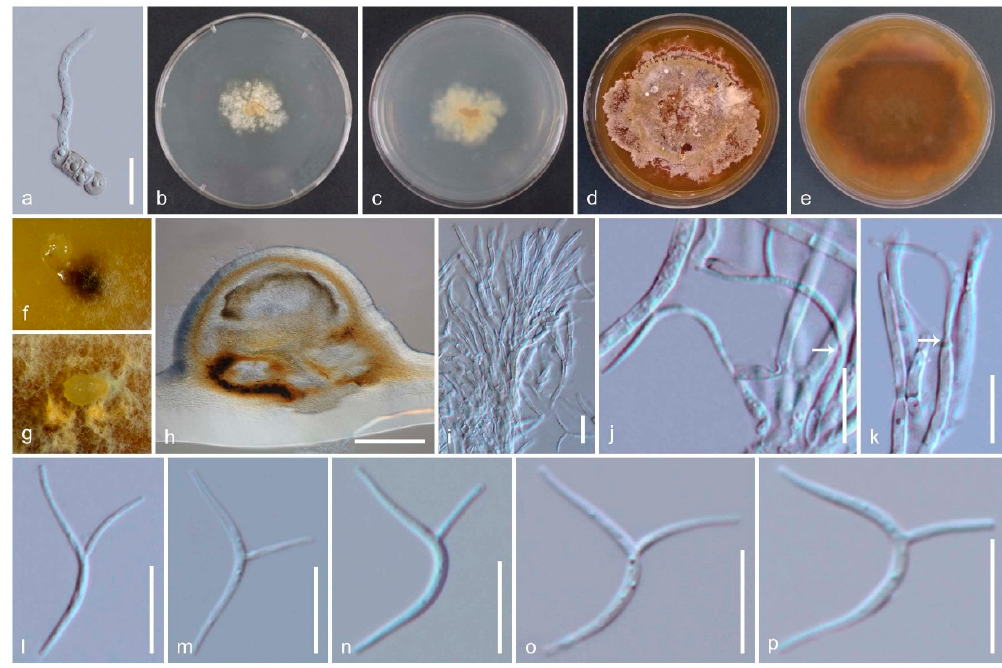
Figure 6. Asexual morph of Amphisphaeria curvaticonidia (MFLUCC 18-0620, ex-type living culture). ( a ) Germinating ascospore; ( b ) upper view, ( c ) reverse view of the 2 weeks old colony on PDA; ( d ) upper view, ( e ) reverse view of the 6 weeks old colony on PDA; ( f , g ) conidiomata in the culture; ( h ) vertical section of conidiomata in dried PDA; ( i – k ) conidiophores, conidiogenous cells, and conidiogenesis (white arrows show conidia attachment); ( l – p ) conidia. Scale bars are set at ( h ) 200 µ m; ( a ) 20 µ m; ( i – p ) 10 µ m.